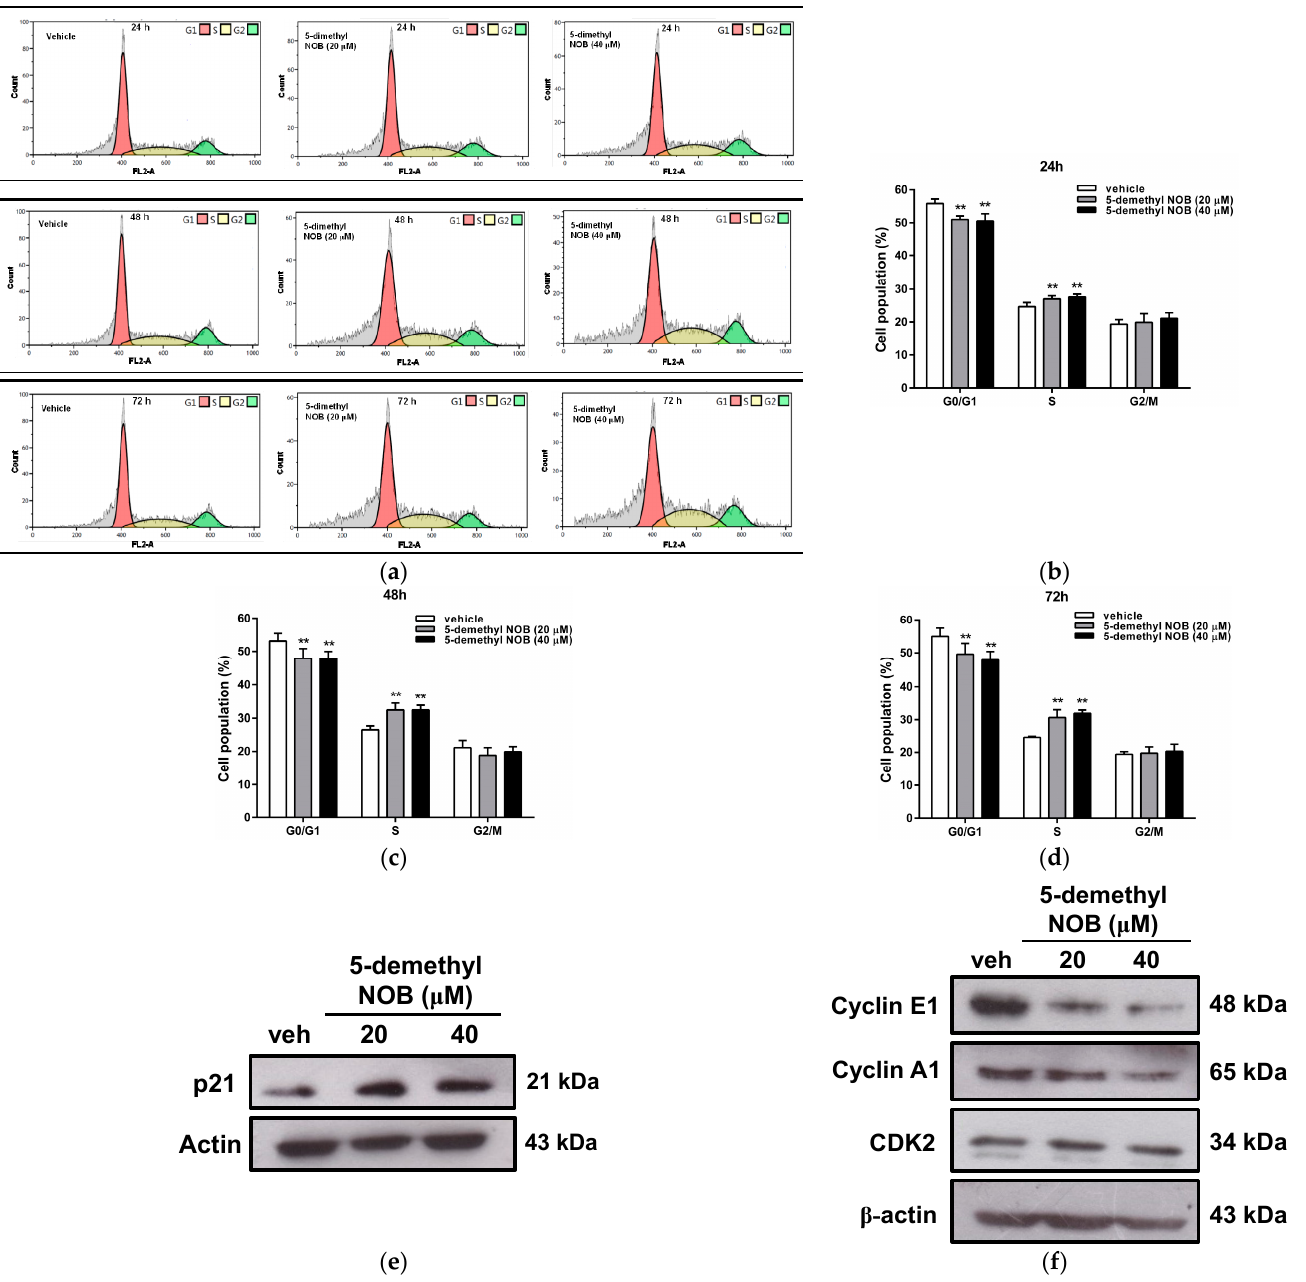
Figure 2. Effects of 5-demethyl NOB on cell cycle distribution and regulatory gene expression. THP-1 cells were treated with vehicle or 5-demethyl NOB (20 and 40 μ M) for 24–72 h, and the cell cycle distribution was detected by flow cytometric analysis. ( a ) A representative histogram of cell cycle distribution. THP-1 cells were treated with 5-demethyl NOB (20 and 40 μ M) for ( b ) 24 h, ( c ) 48 h, and ( d ) 72 h, and the cell populations in G0/G1, S and G2/M phases were quantified. The data represent the mean ± SD of three independent experiments. ** p < 0.01 represents significant differences compared to the vehicle-treated group. Western blot analysis of ( e ) p21, ( f ) cyclin E1, cyclin A1, CDK2 and actin expression in THP-1 cells treated with vehicle or 5-demethyl NOB (20 and 40 μ M) for 48 h.